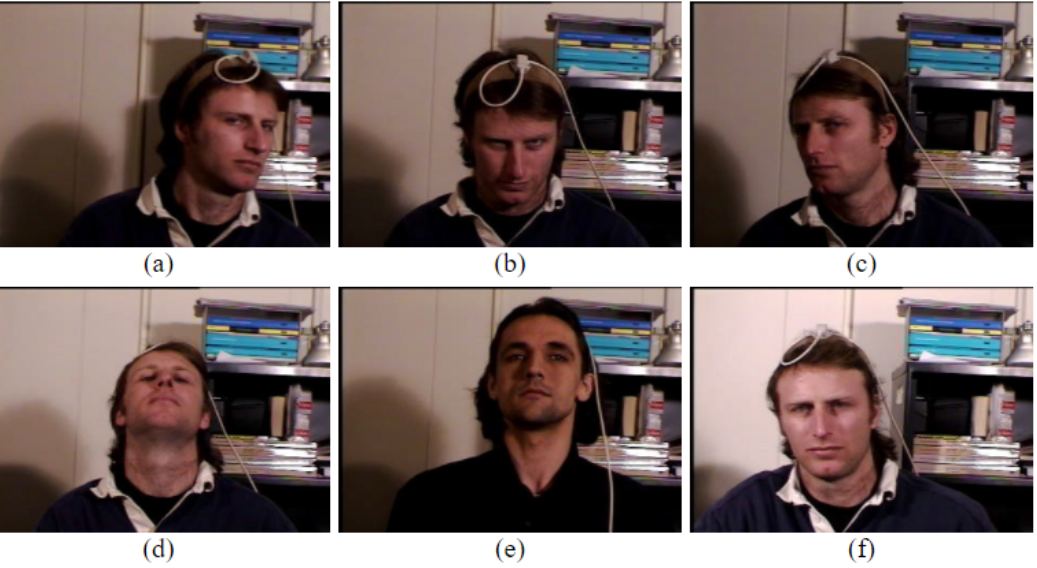
Figure 5. Different frames of the BU dataset showing distractions, namely: ( a ) head panning towards left, ( b ) head nodding down, ( c ) head panning towards right, ( d ) head nodding up, ( e ) facing forward with distracted eyes, and ( f ) looking